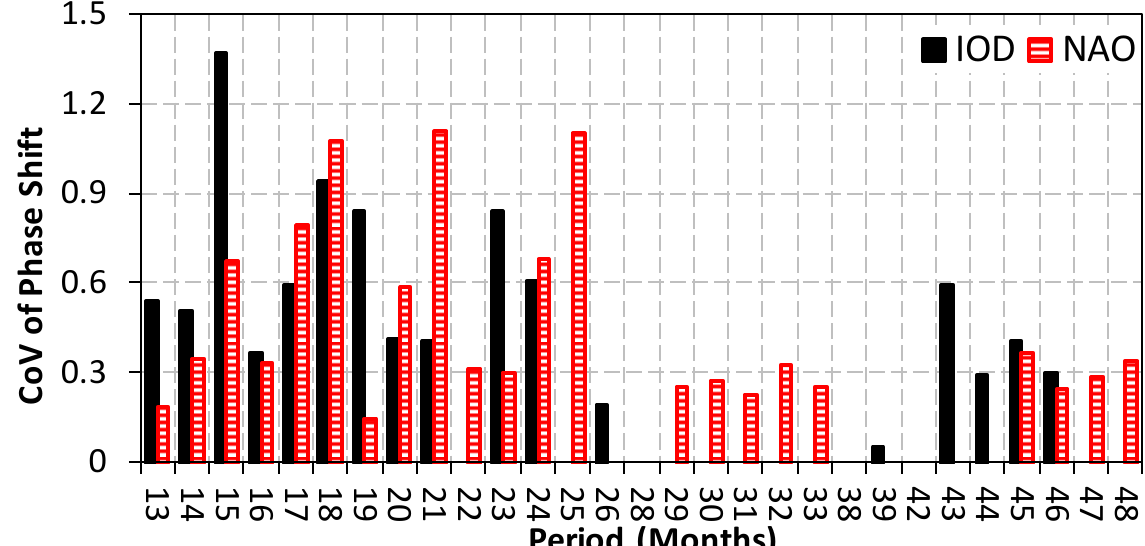
Figure 14. Coefficient of variation values for phase shifts according to the periods. Inverse-distance-weighted (IDW) spatial interpolation was performed on phase shift values and was then mapped for the NAO (Figure 15a) and IOD (Figure 15b). Similar spatial interpolations were performed for CPSD values, which were then mapped for the NAO (Figure 16a) and IOD (Figure 16b).